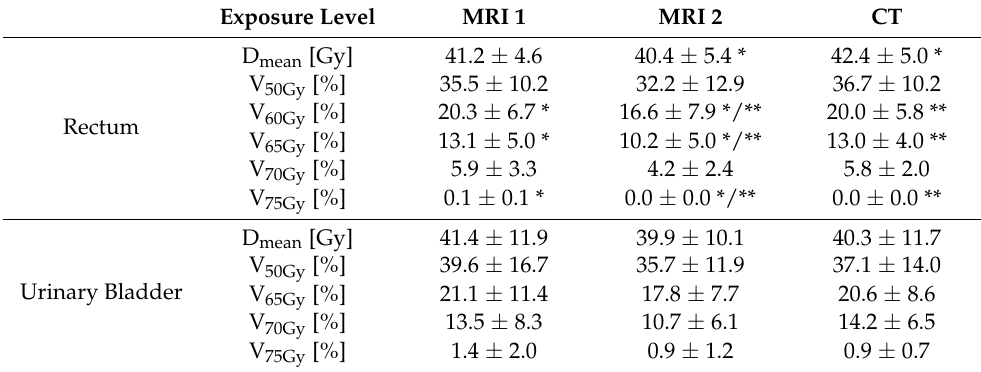
Table 4. Exposure of Organs at Risk.